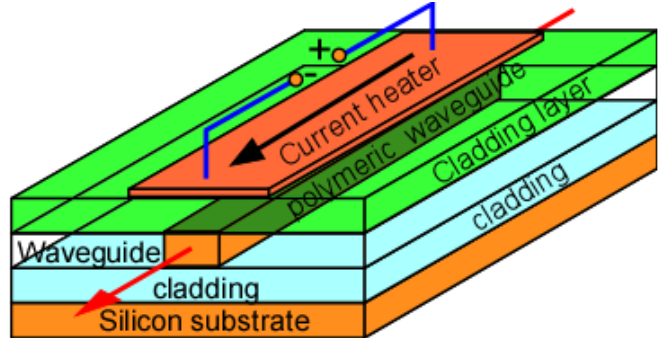
Figure 2. Schematic structure of the thermo-optic (TO) phase encoder. It consists of a polymeric waveguide with a top electrode. The top electrode and the polymeric waveguide are separated by a cladding layer. Local heating in the polymeric waveguide can be achieved by applying current through the top electrode. The local current heater increase the temperature of the polymeric waveguide and lead to refractive index change through the TO effect of the polymeric waveguide. The refractive index change will result in phase shift of the optical signals in the